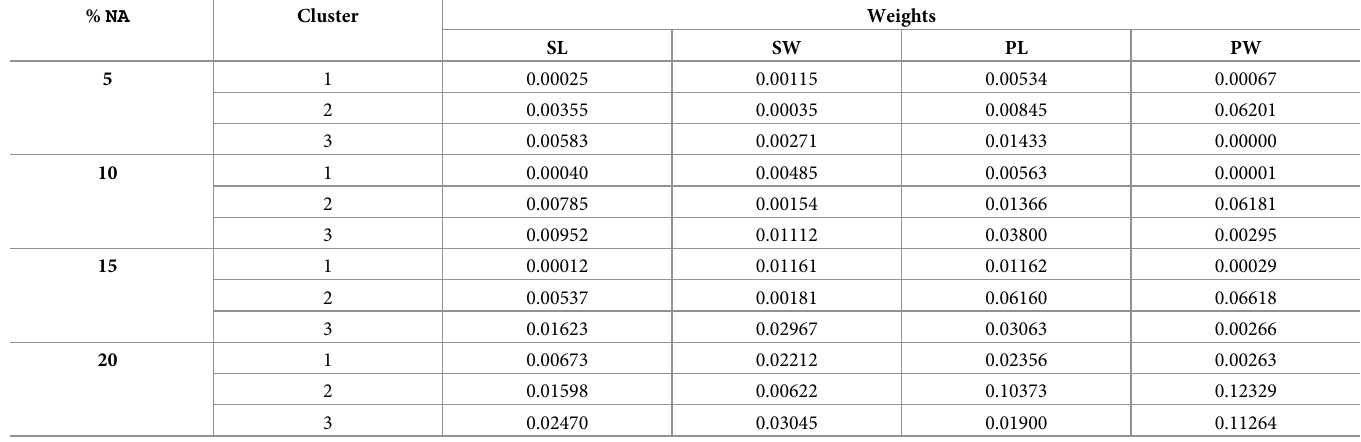
Table 6. Consistency of variables for the dataset Iris Plant